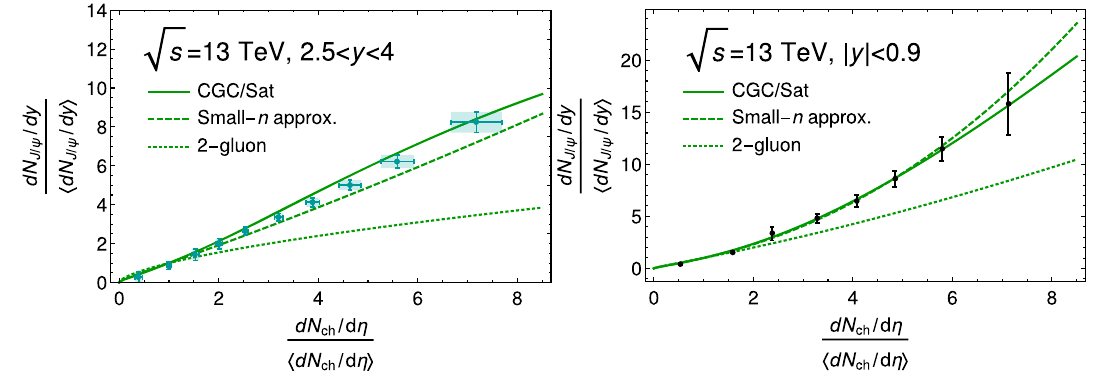
Fig. 6 Left: multiplicity dependence at forward rapidities (2 . 5 < y J /ψ < 4), when charged particles are collected at central rapidities ( | η | < 1). Experimental data are from [73]. Right: evaluation at central rapidities ( | y J /ψ | < 0 . 9). Due to overlap of the bins of charmonium and charged particles, we have an additional contribution of the nonlinear term33,whichleadstoamorepronounced n -dependence.Experimental